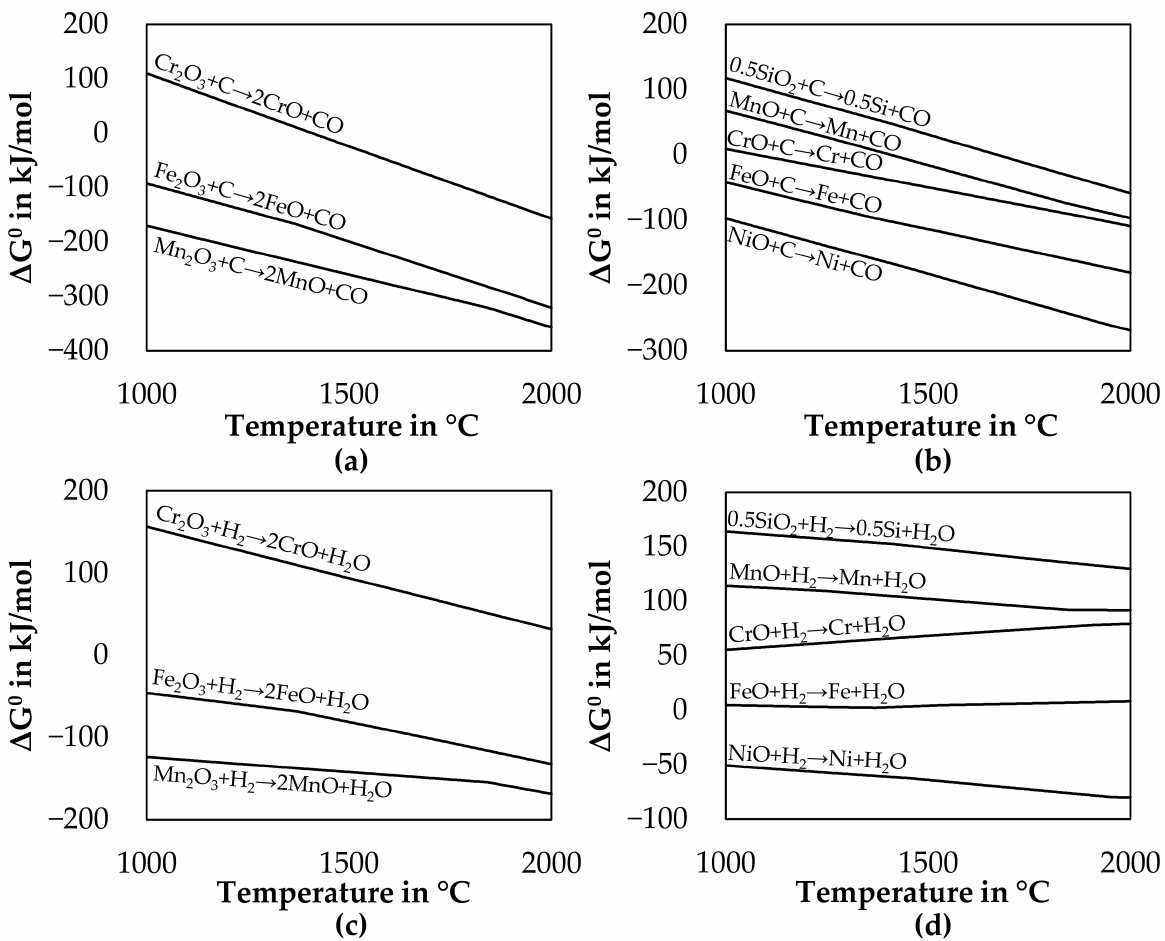
Figure 1. Gibbs free energy of reduction reactions per mole reducing agent. ( a ) pre-reduction with carbon; ( b ) reduction with carbon; ( c ) pre-reduction with hydrogen; ( d ) reduction with